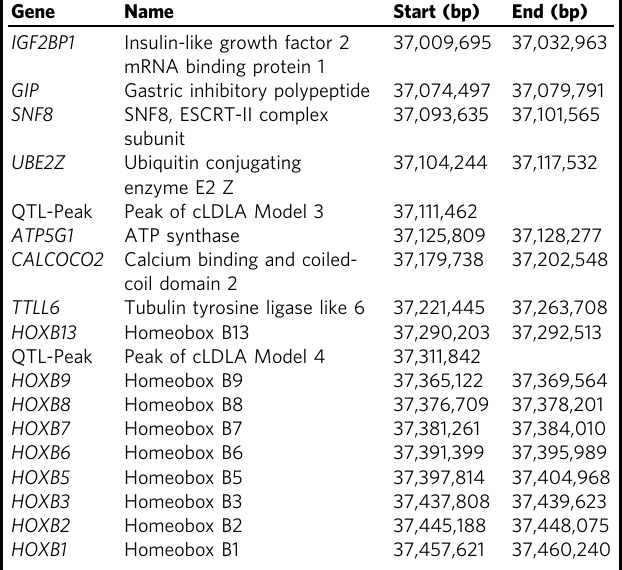
Table 3 Genes on OAR11 between positions 37,000,925 bp and 37,521,490 bp as well as the genome-wide signi fi cant peaks of cLDLA model 3 and